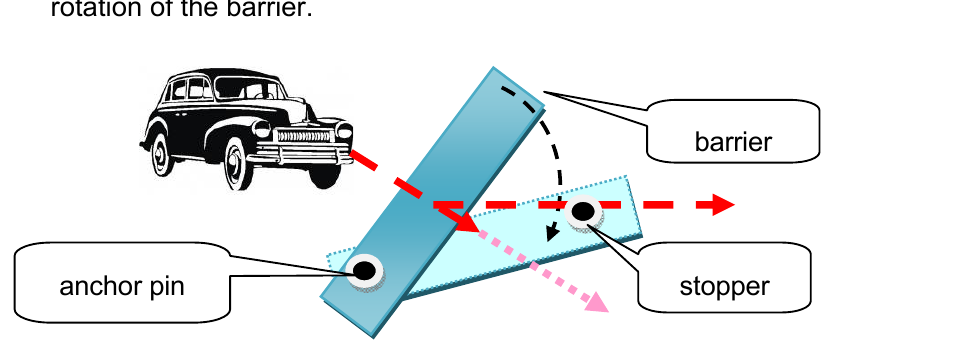
Рис . 5 – Одностороннее крепление блока барьера к основанию